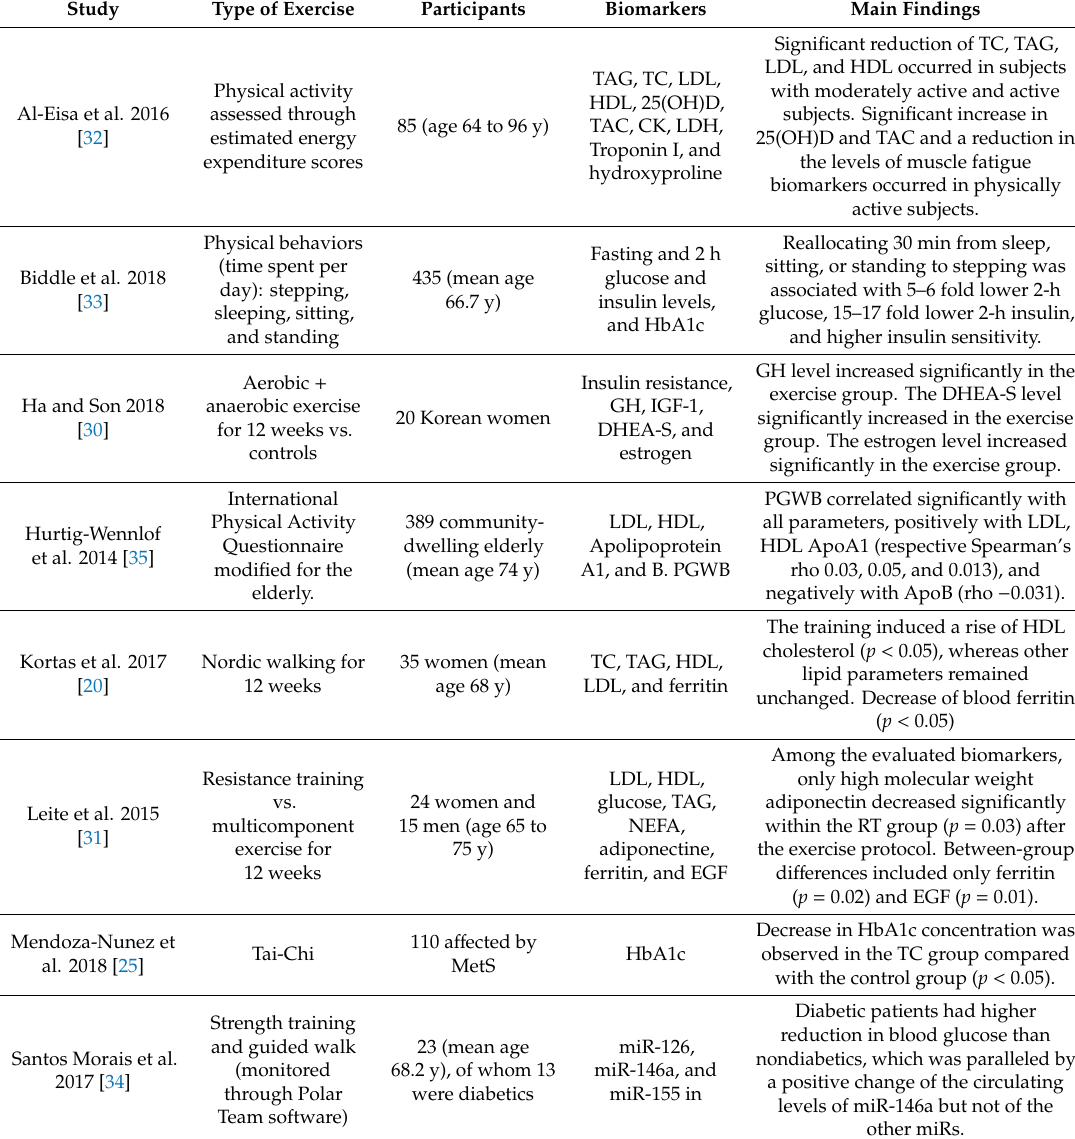
Table 3. Metabolic